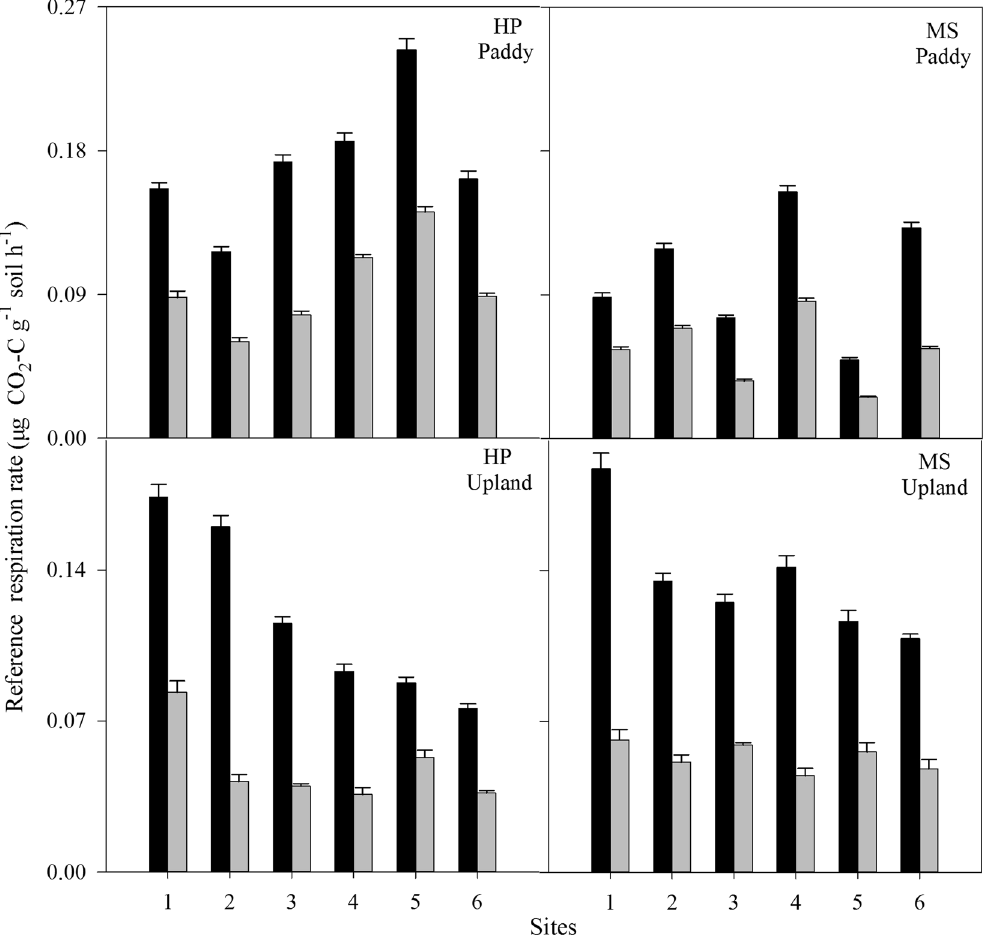
Figure 2. SOC decomposition rate (at 20 °C) in topsoil layer (TL, black bars) and subsoil layer (SL, gray bars). Error bars indicate standard deviation (n = 4). Means are the average decomposition rates for six sites. HP and MS represent Huaping and Meishan,